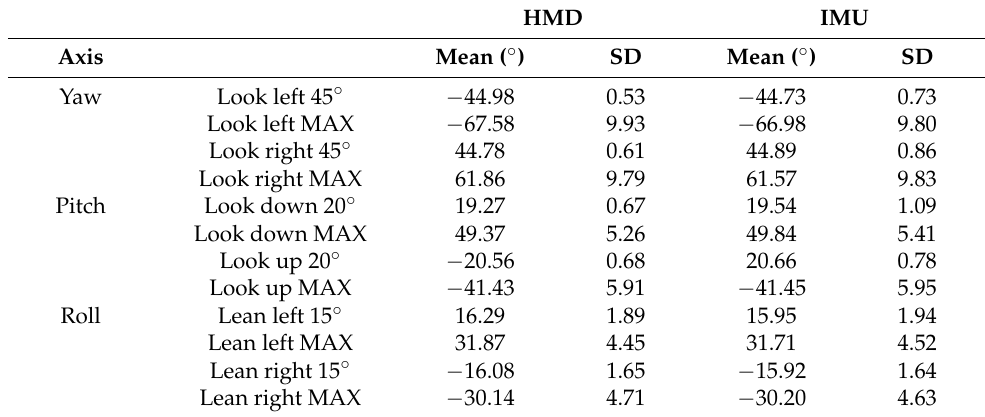
Table 1. Descriptive outcomes of neck movement obtained from both measurement devices.